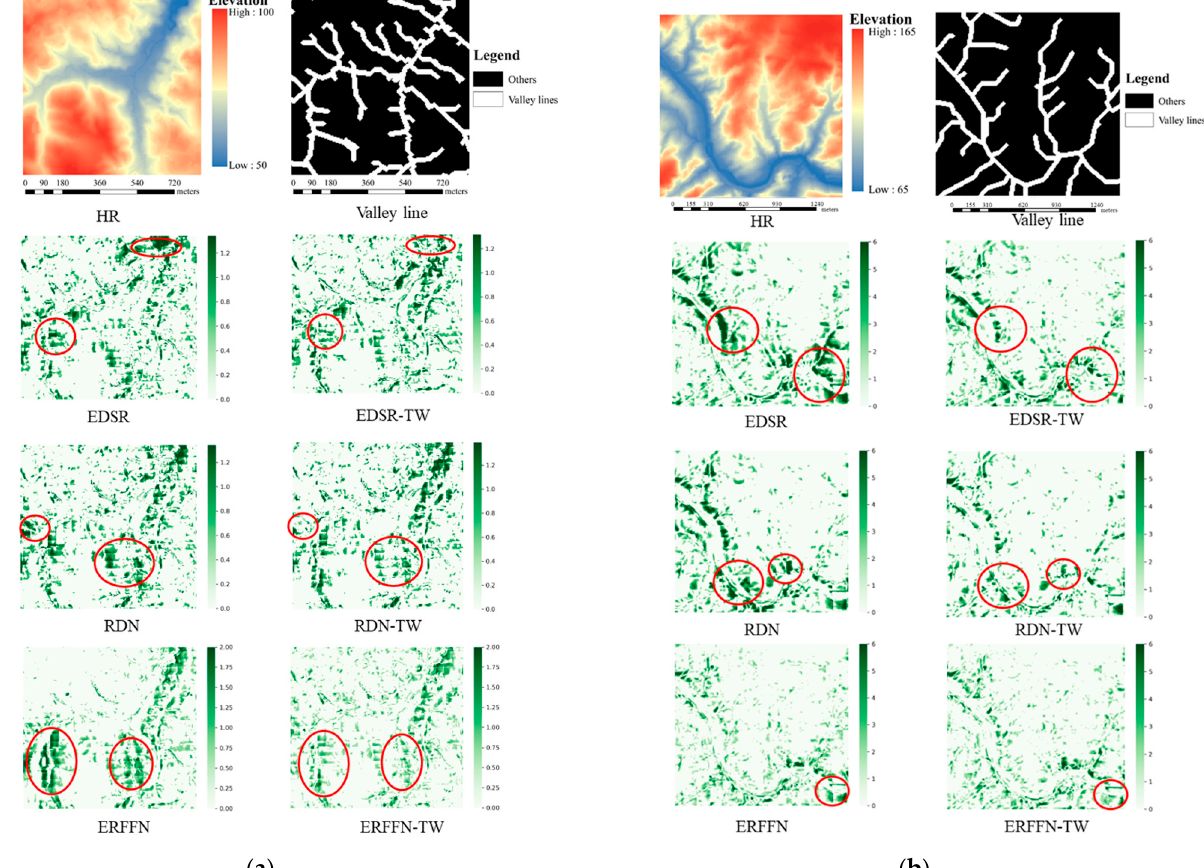
Figure 14. ( a ) The reconstruction of 5 m DEMs of the ablation study of the terrain weight loss module of different methods. ( b ) The reconstruction of 10 m DEMs of the ablation study of the terrain weight loss module of different methods. The red circle circles the obvious places of contrast.